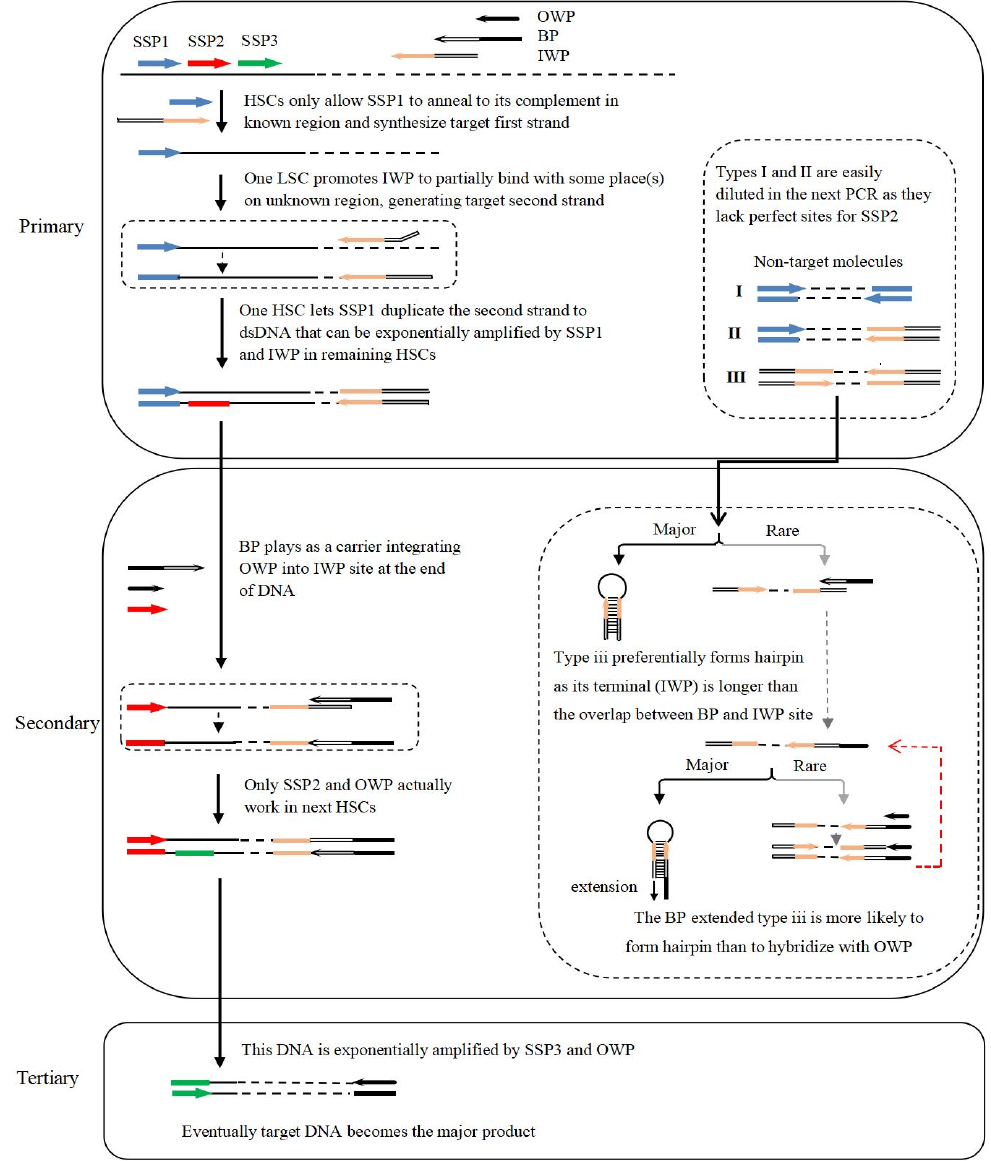
Figure 1. Schematic diagram of bridging PCR. ISP: inner walker primer; BP: bridging primer; OWP: outer walker primer; and SSP: sequence-specific primer. Thin solid lines: known sequences; thin dotted lines: unknown sequences; color thick arrows: primers; color thick lines: primers complements; ssDNA: single-stranded DNA; dsDNA: double-stranded DNA; HSC: high-stringency cycle; LSC: low-stringency